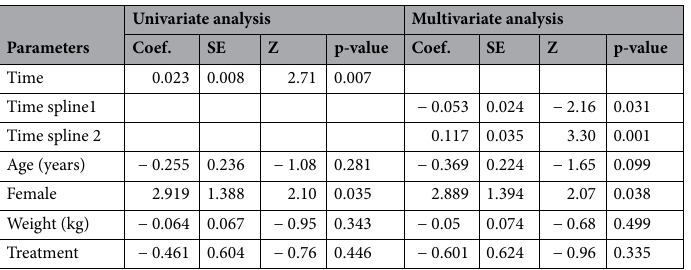
(Table S4, Figure S1B). In summary, low-density P. falciparum infection accelerated telomere shortening in all study participants within 64 days. Complete restoration of TL followed from day 22 and was fully established upon day 64 post infection. Kinetics of cellular aging, cytokine expression and anti-oxidant levels prior, during and post infection. Results reveal the manifestation of a pro-inflammatory status, with the increase of six cytokines (all p < 0.05, Fig. 2A, Table S6) upon day after treatment 1 (DT+1), followed by a decrease in their expression post final treatment (C+64, all p < 0.05), with exception of IL-12p70. When comparing pre infection (C-1) with